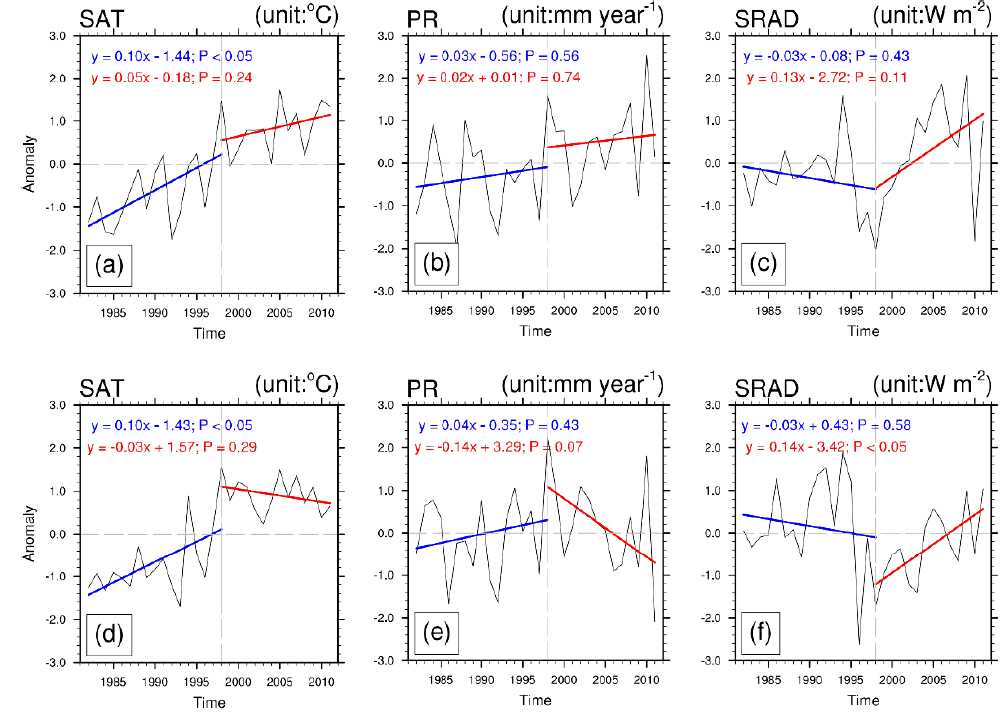
Figure 4. Changes in growing-season-average climate drivers (SAT: surface air temperature; PR: precipitation; SRAD: solar radiation) for the ( a – c ) whole terrestrial ecosystem and ( d – f ) China over the period of 1982 – 1998 (red) and 1999 – 2012 (blue), where SAT, PR or SRAD (y) is calculated by the time (x) using a linear regression, p represents significant level.